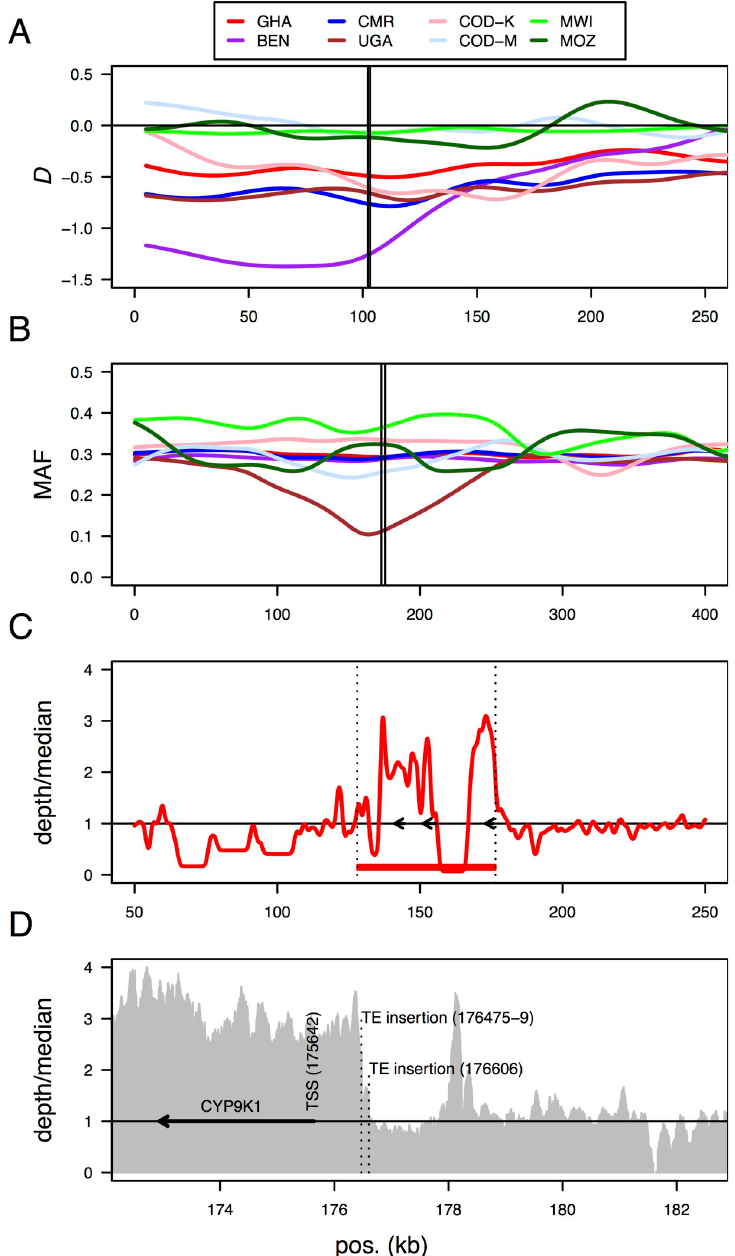
Fig 6. Signatures of selection spanning other resistance associated genomic loci. A) A selective sweep spanning a Glutathione S-transferase (GST) epsilon gene cluster associated with DDT and pyrethroid resistance in Benin (BEN). The gene cluster contains GSTe2 , which is highly over-expressed in Benin. Lines are kernel-smoothed Tajima’s D values calculated for 10 kb windows moving in steps of 5 kb. The vertical lines indicate the start and end of the GSTe cluster. (B) Loss of genetic diversity (reduced minor allele frequencies, MAF) spanning a highly over-expressed CYP9K1 P450 gene on the X chromosome in Uganda. Lines are kernel-smoothed minor allele frequencies (MAF) as these showed the sweep more clearly that Tajima’s D. The vertical lines indicate the start and end of the CYP9K1 gene. (C) Increased copy number in the Uganda population of a region of the X chromosome containing three genes (arrows), from left to right: AFUN007547, AFUN007548 and AFUN007549 ( CYP9K1 ). The red line indicates coverage depth relative the genomic median, with a horizontal black line at 1. The red rectangle and vertical dotted lines indicate the putative duplicated region. (D) One edge of the region of increased coverage depth (the grey plot) on the X chromosome in the Uganda population, upstream of the CYP9K1 gene (black arrow), corresponds to a putative transposable element insertion in the genomes of mosquitoes in Tororo, Uganda.